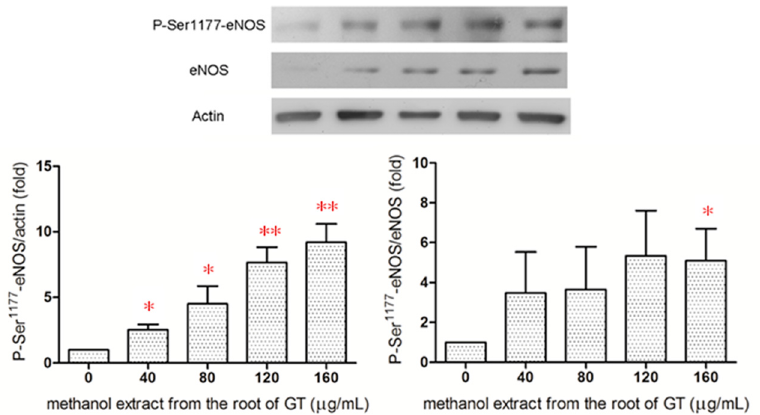
Figure 5. Effect of the R/M GTE on eNOS activation. HUVECs were treated with R/M extract for 15 min. Total eNOS protein content and phospho-eNOS (P-Ser 1177 -eNOS) were determined by Western blot analysis. Data were obtained from four replicate experiments, and are expressed as mean ± standard deviation. A significant difference from the vehicle was indicated as * p < 0.05 or ** p < 0.01 (Student’s t -test).